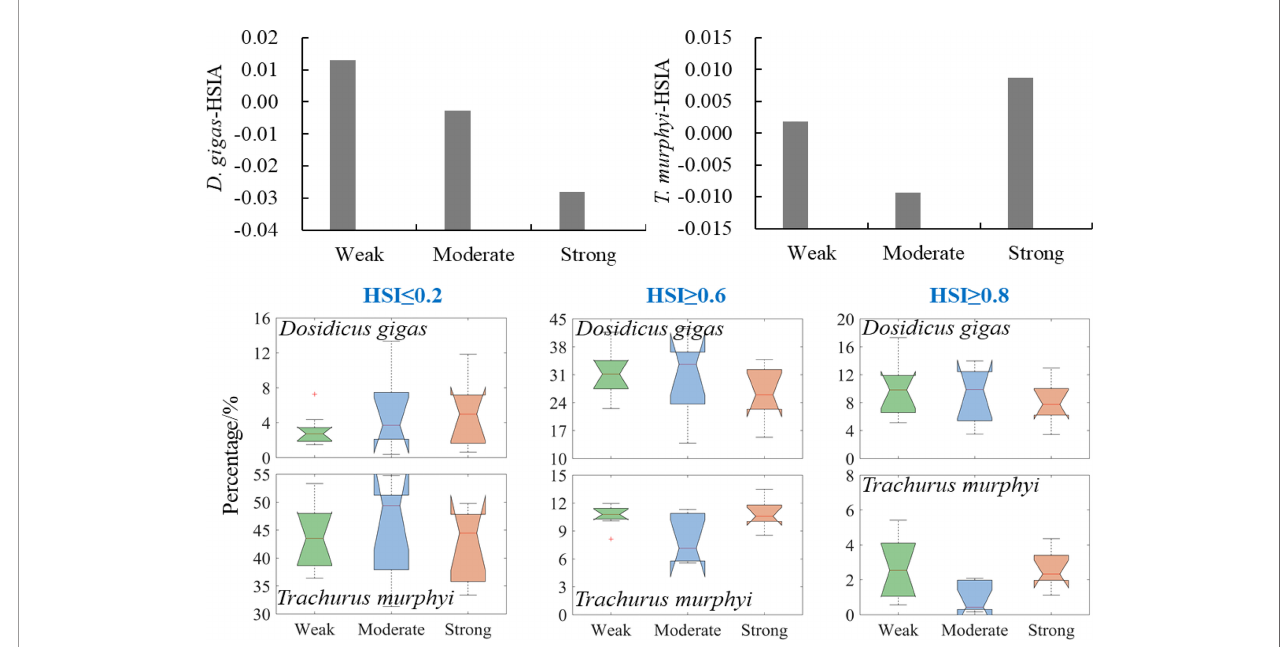
FIGURE 5 | Changes in proportion of poor, suitable, and optimal habitat areas of Dosidicus gigas and Trachurus murphyi under El Niño events with different intensities. (The nodes of the boxplot from top to bottom are the upper edge, upper quartile, median, lower quartile, and lower edge, with “ + ” representing